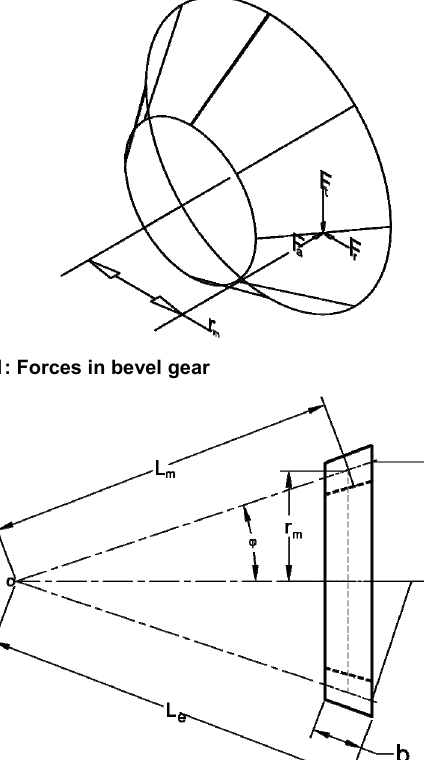
Fig. A2: Axial plane of bevel gear Gear